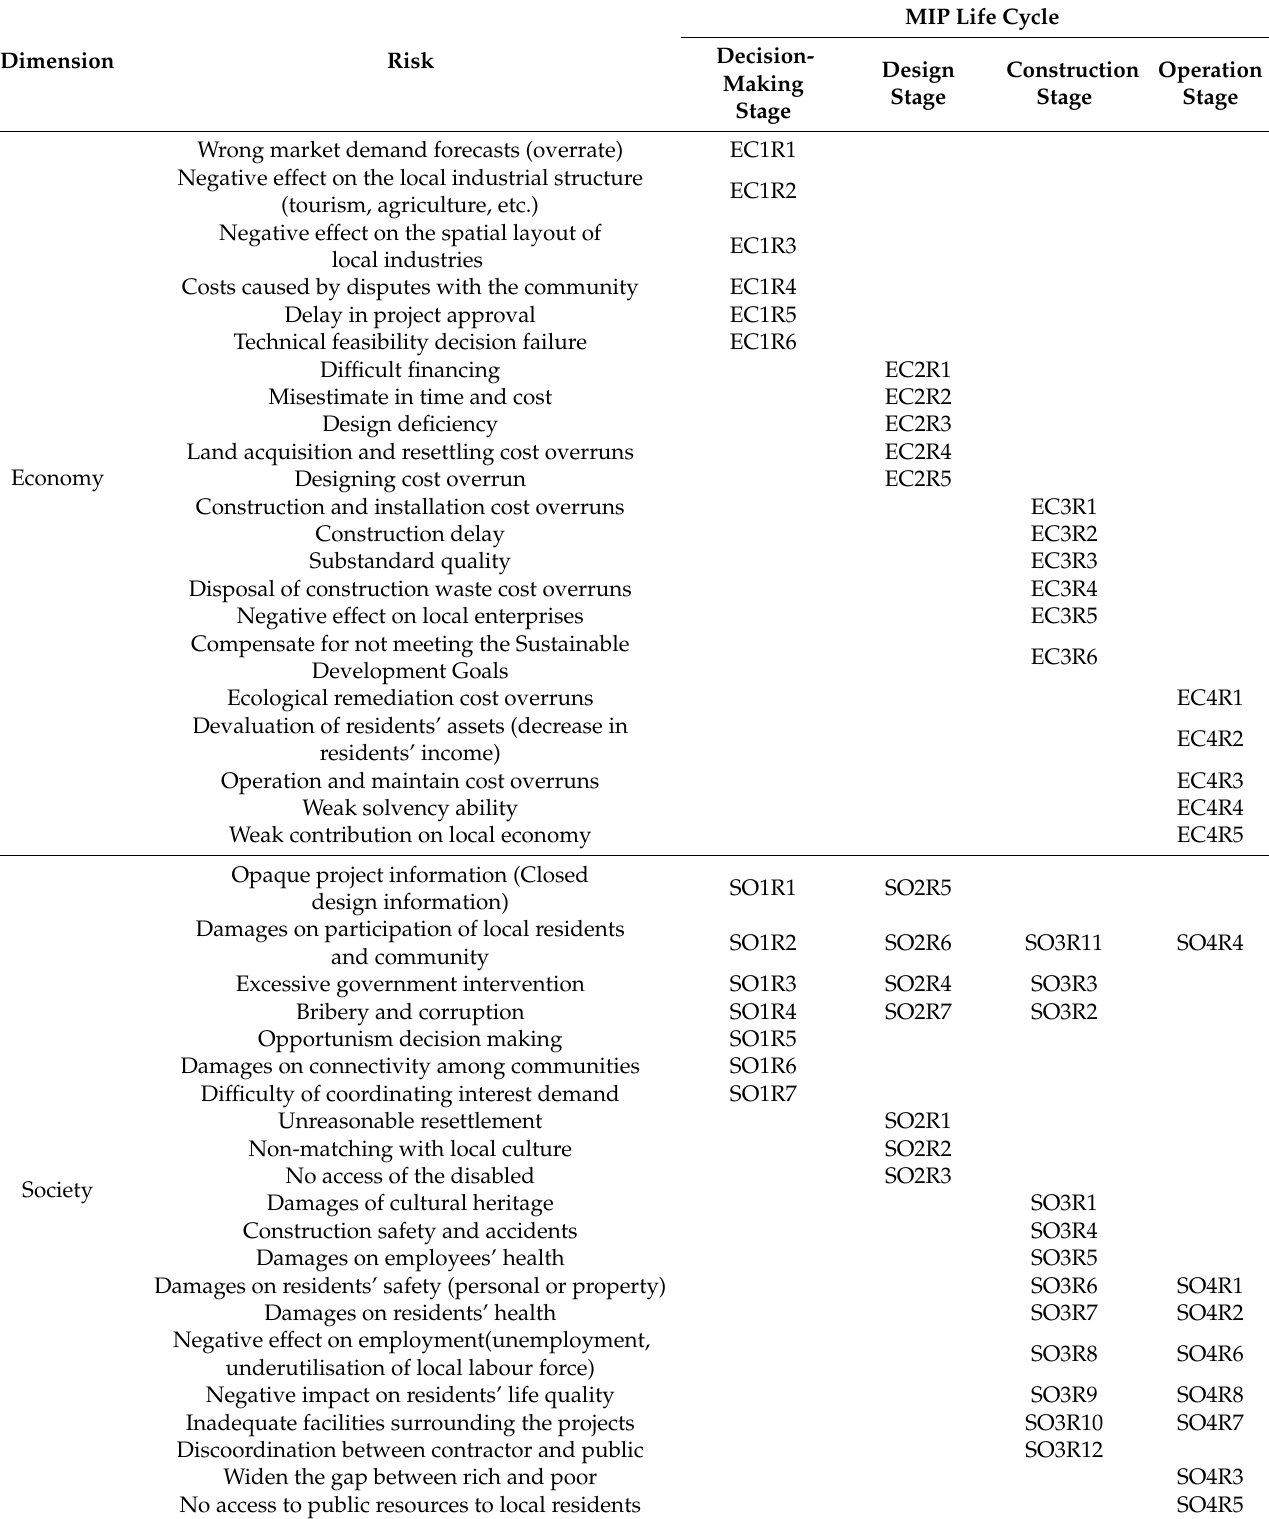
Table 2. Risk list of